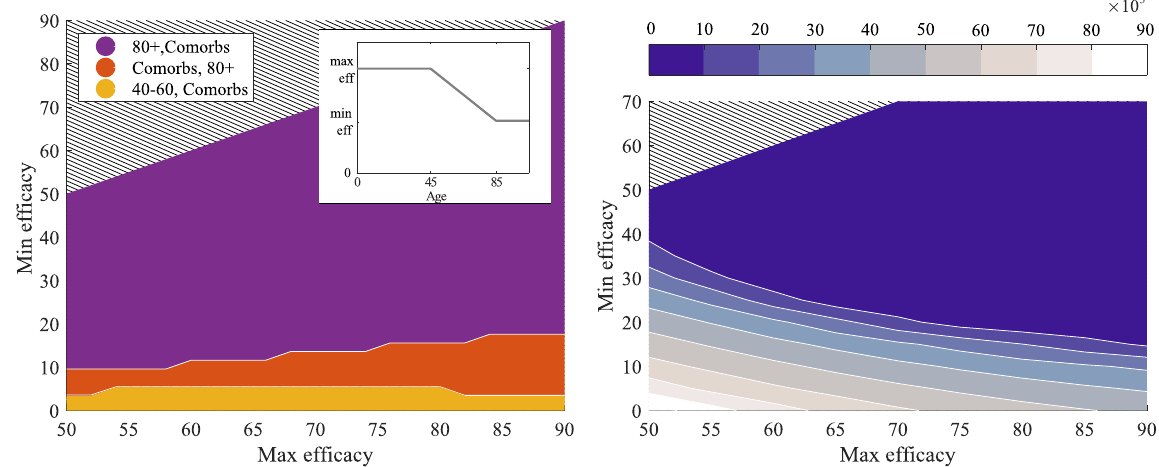
Fig 9. The effect of different levels of declining type 1 vaccine efficacy ( R � 1.8) on both the optimal vaccine ordering and success at limiting mortality. A maximum efficacy value is applied to all individuals below the age of 45 and a minimum level to individuals above the age of 85. Efficacy is assumed to decay linearly between these two levels to give the efficacy for intermediary age groups. This distribution is represented by the inset in left panel. The left panel shows when, dependent on minimum and maximum efficacy, the two groups deemed most significant for vaccination impact vary. In the purple region it is optimal to vaccinate those above the age of 80 followed by comorbidities, in the red comorbidities followed by 80+ and in the yellow those in the 40-60 age group followed by comorbidities. The right panel shows the expected further mortality following vaccination with 70% of the whole population vaccinated for different minimum/maximum type 1 vaccine efficacies. The large dark blue region corresponds to less than 10,000 deaths following vaccination.